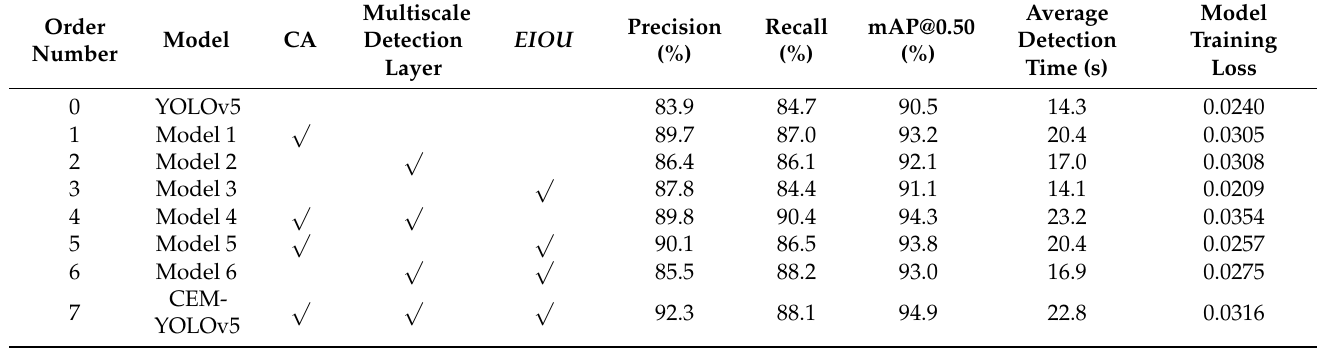
Table 5. This is a table that evaluates the impact of different improvement schemes on model detection performance: Models 1–3 are single module improvement experiments, Model 1 integrates the CA attention mechanism, Model 2 expands the detection layer, Model 3 uses the EIOU loss function, and Models 4–6 are the improvement experiments of the two modules. Model 4 is the fusion CA attention mechanism and the extended detection layer, Model 5 is the fusion CA at-tention mechanism and the use of the EIOU loss function, and Model 6 is the extended detection layer and the use of the EIOU loss function.